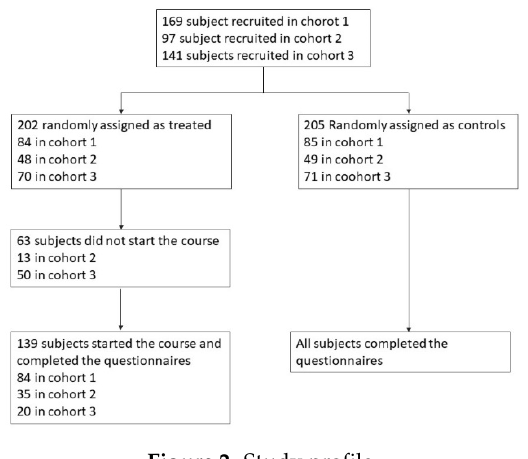
Figure 2. Study Figure 2. Study profile.